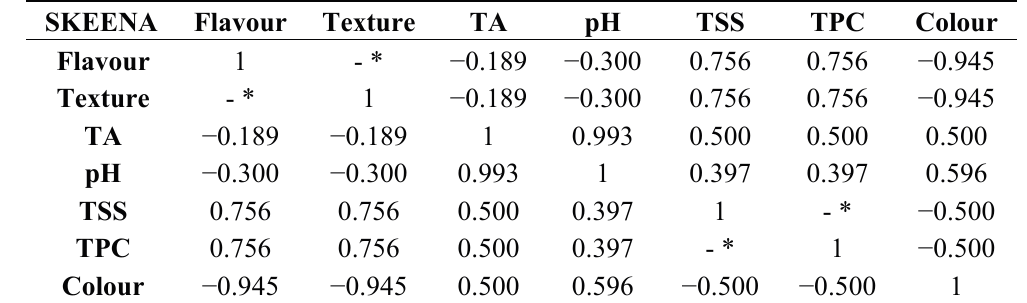
Table 11. Correlation between physicochemical and sensory attributes in the Skeena